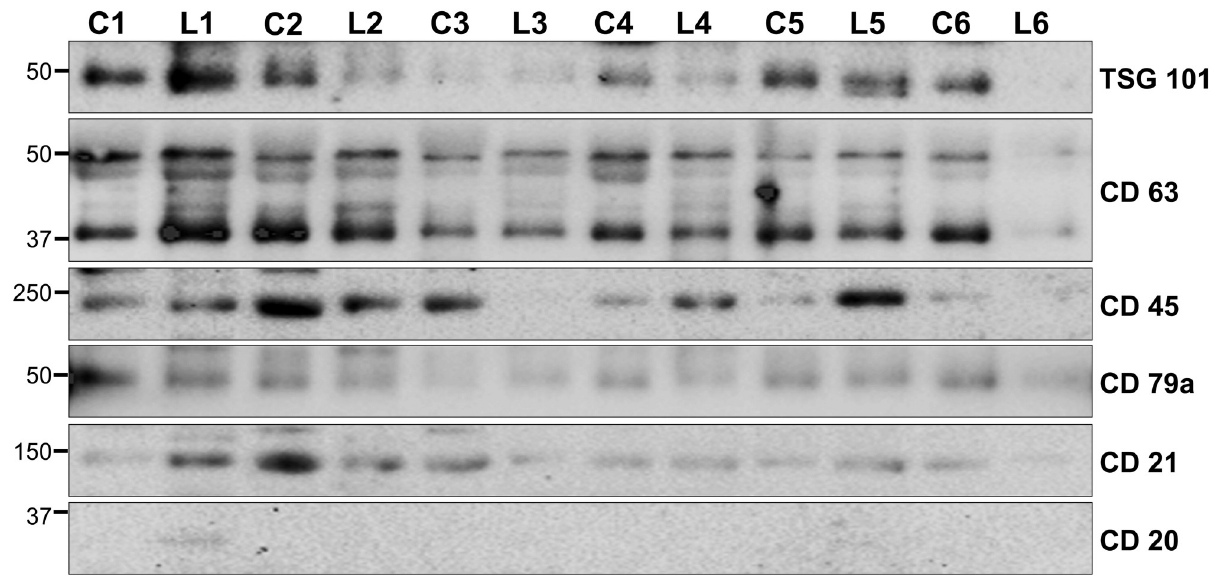
Fig 2. Western blot analysis of protein lysates from isolated from canine